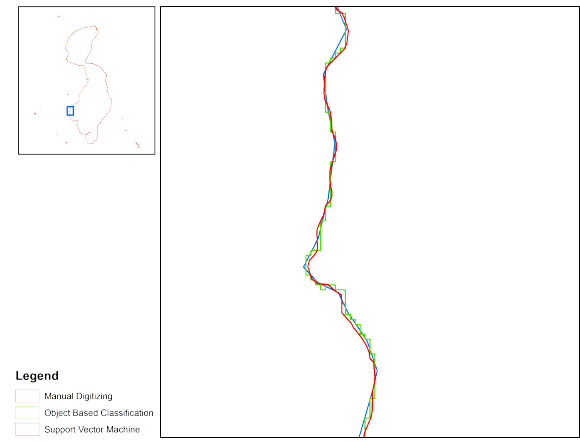
Figure 3. Comparison of coastline detection results in GIS 10 random points have been created on vector file of manual digitizing result to measure Euclidean distances of these points to OBC and SVM classification results. Results shown that